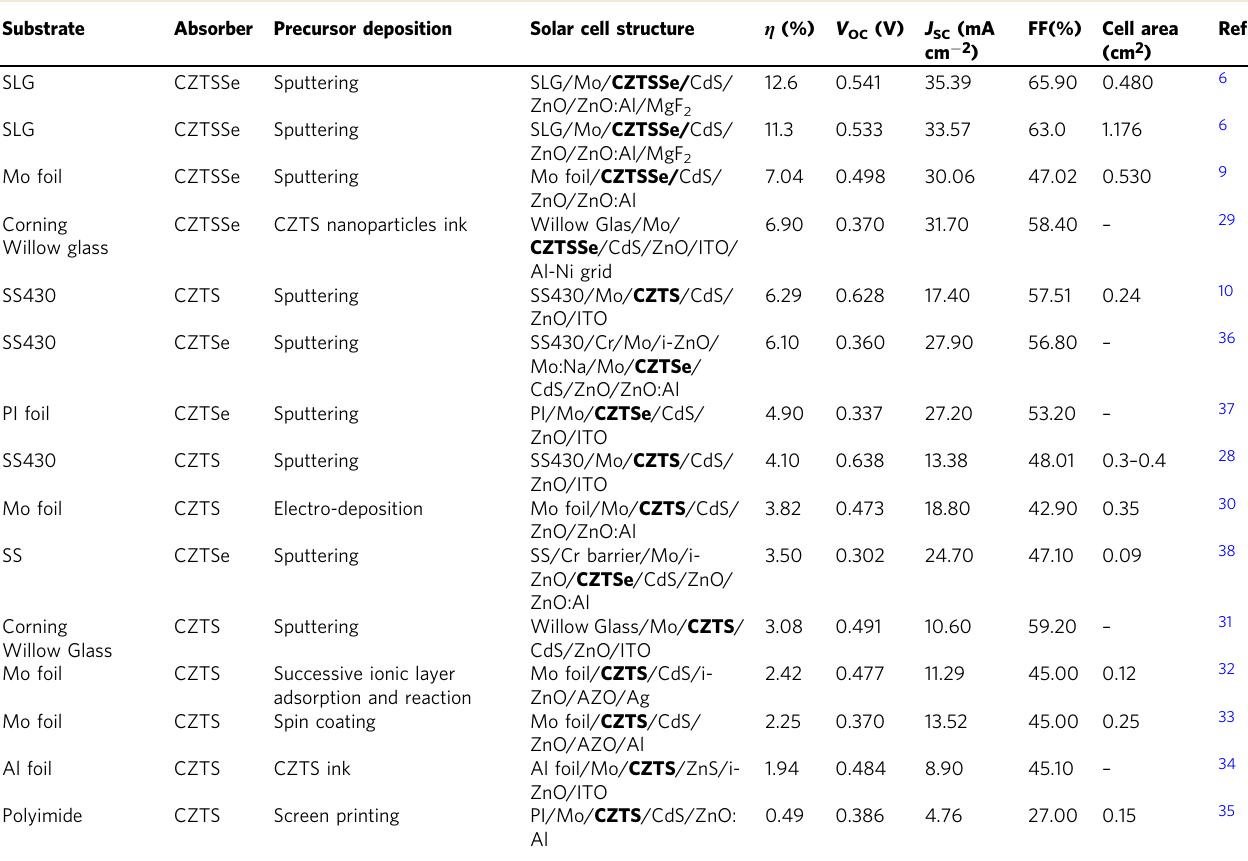
Table 1 Summary of reported kesterite solar cells on fl exible substrates and the highest ef fi ciency CZTS-based solar cells on SLG substrates with small and large areas